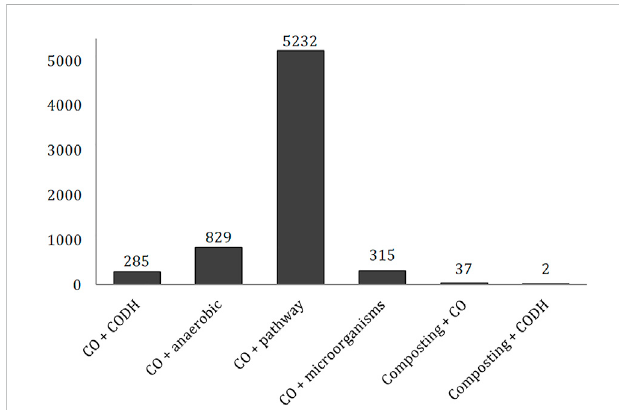
FIGURE 1 Number of publications in the Web of Science Core Collection for chosen combination of keywords.